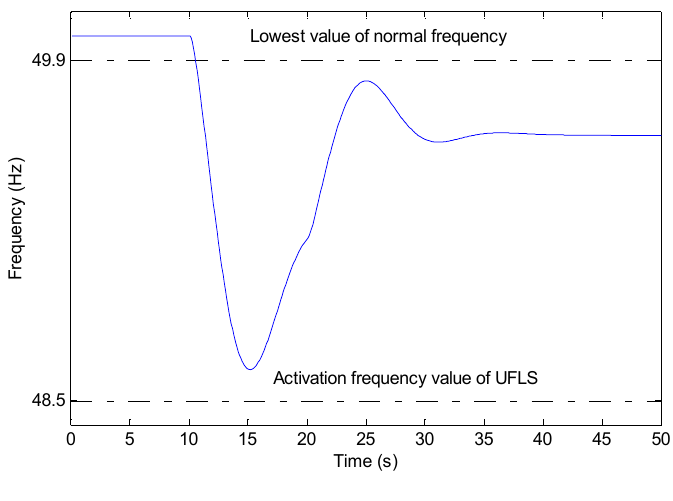
Figure 4. Activation frequency